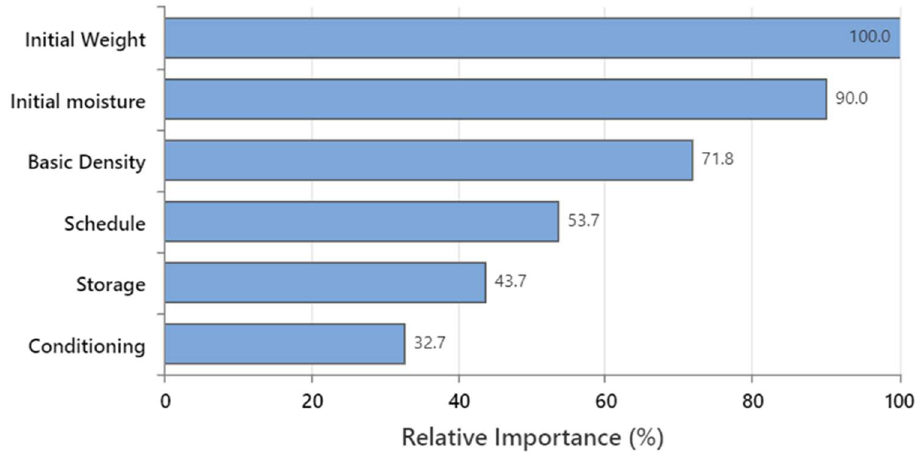
Figure 11. The relative importance of the inputs used to train the random forest approach for the M f classifier model.